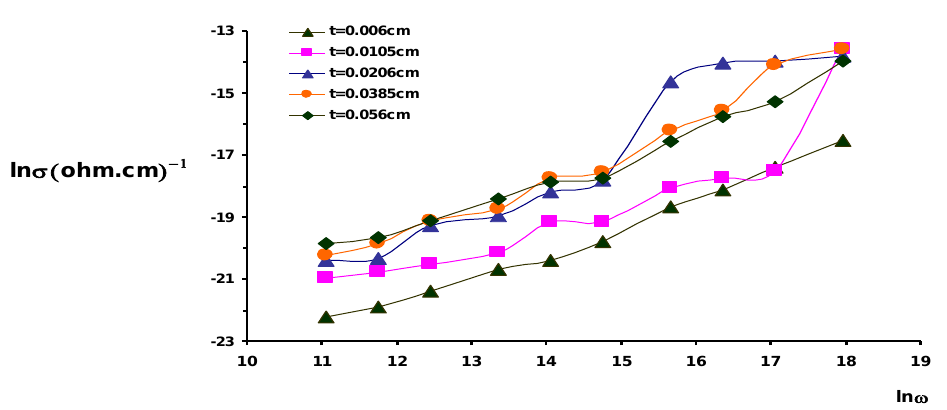
Fig.6: Frequency dependence of AC conductivity for PMMA film of different thickness at room temperature.